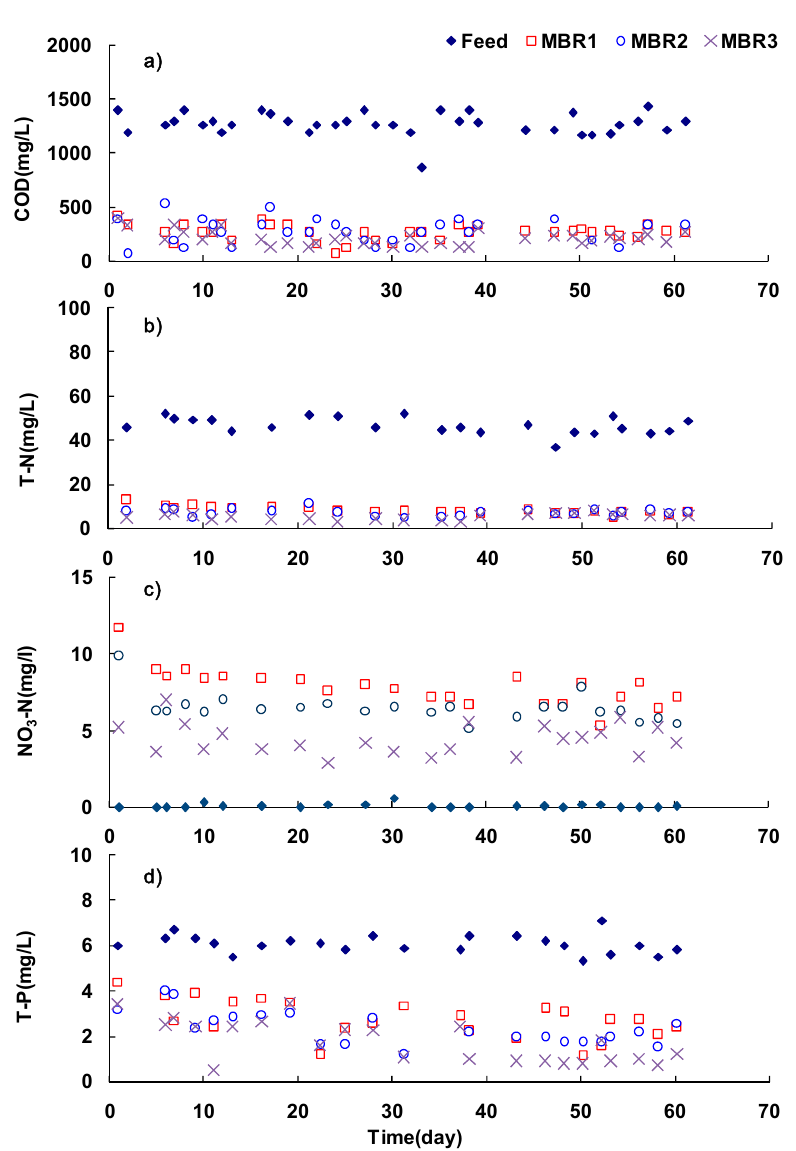
, MBR2: ( a ) COD; (cid:35)